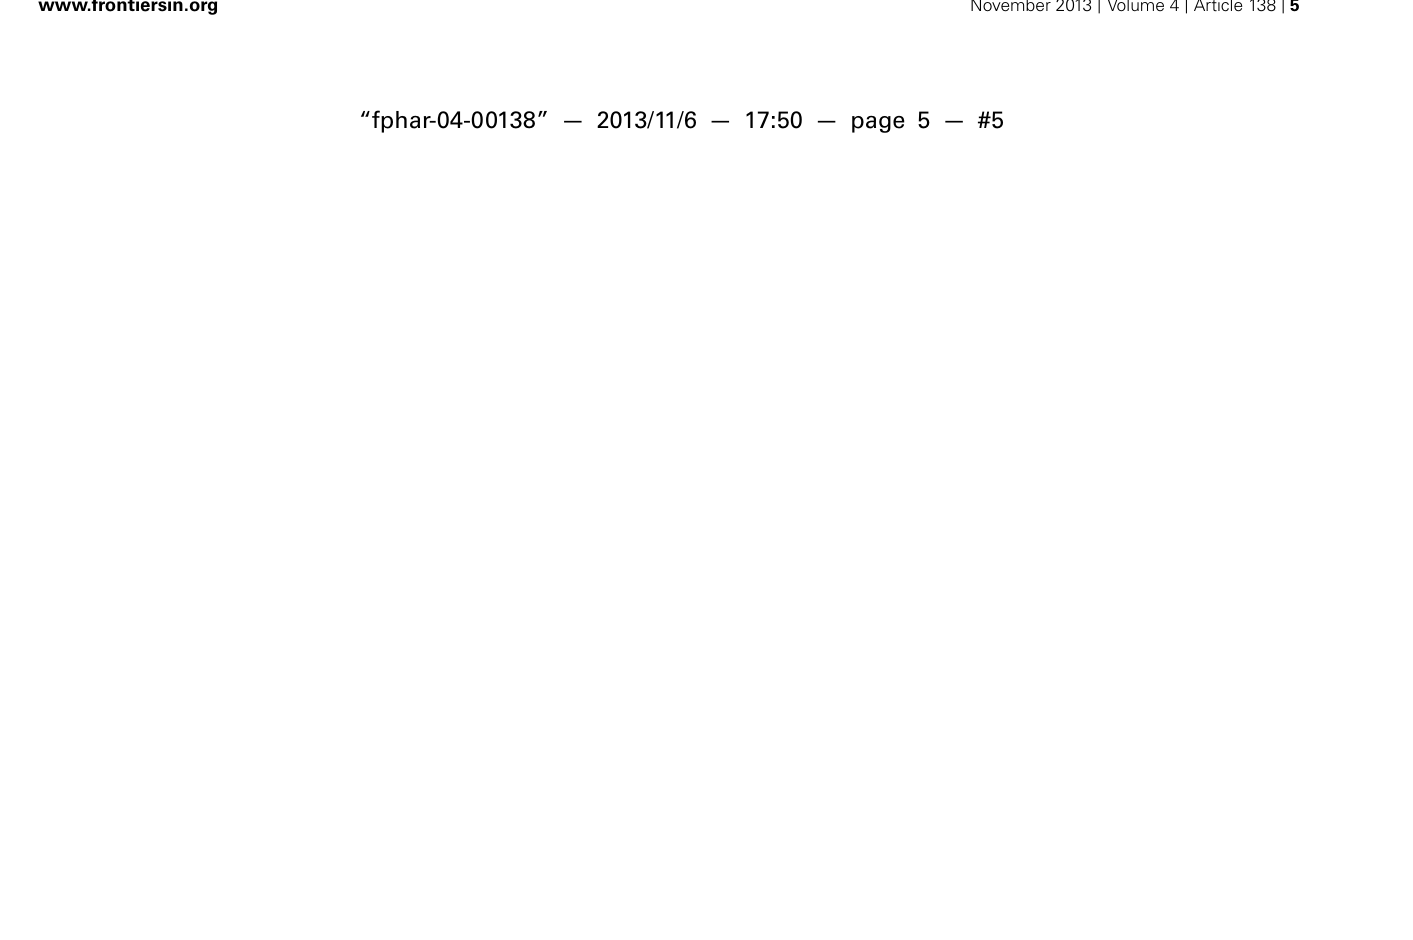
unchanged. It was not either correlated to any ABCG2-specific collateral sensitivity in MTT cell survival assays (D) with ABCG2-overexpressing cells (white circles) and control cells (black circles). The values represent means ± SD corresponding to at least two independent experiments performed in triplicates. t -test analysis: * p < 0.05, ** p < 0.01, and *** p <